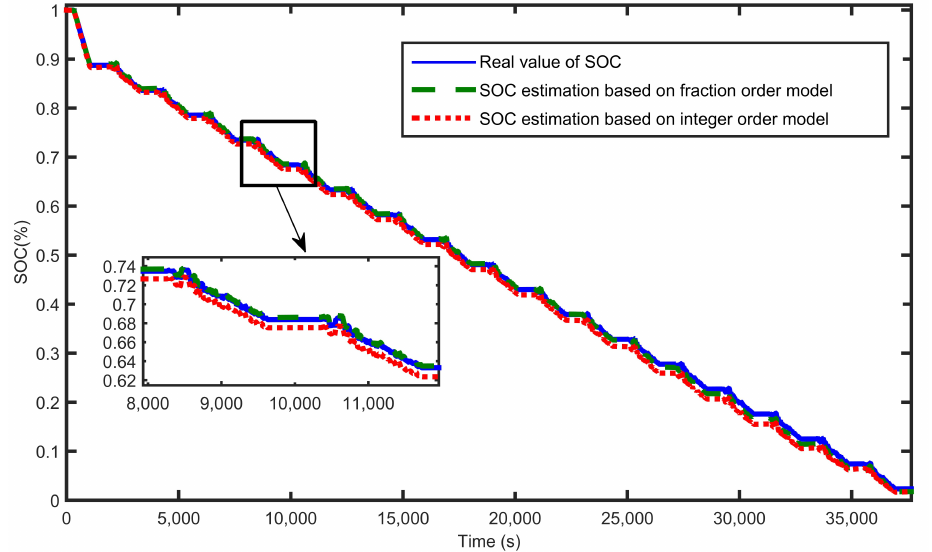
Figure 30. Comparison of SOC estimates based on fractional-order model and integer-order